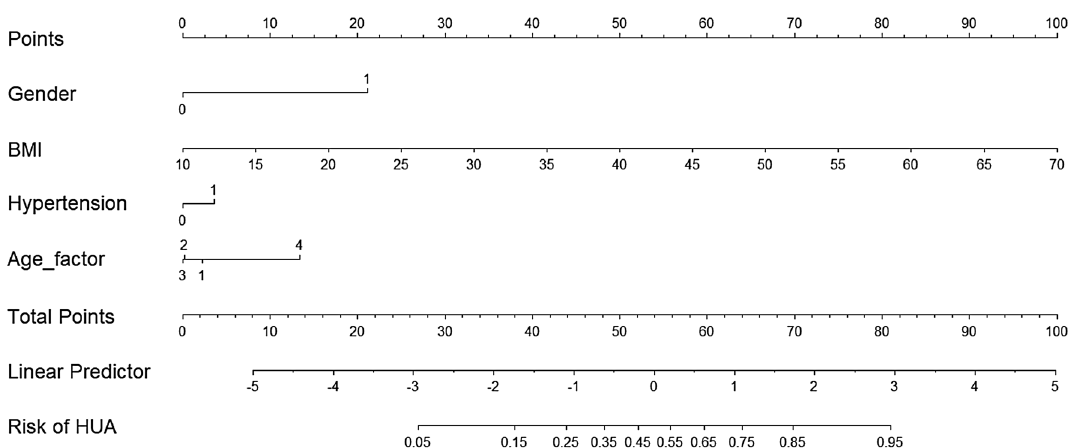
Figure 1. The usage method of nomogram to predict the risk of HUA. The scores were calculated according to the following factors (gender, BMI, hypertension and age) of the enrolled patients, and sum the total scores was used to calculate the risk of HUA. The figure was created by using R software (version 4.0.0), URL: https:// www.r- proje ct.